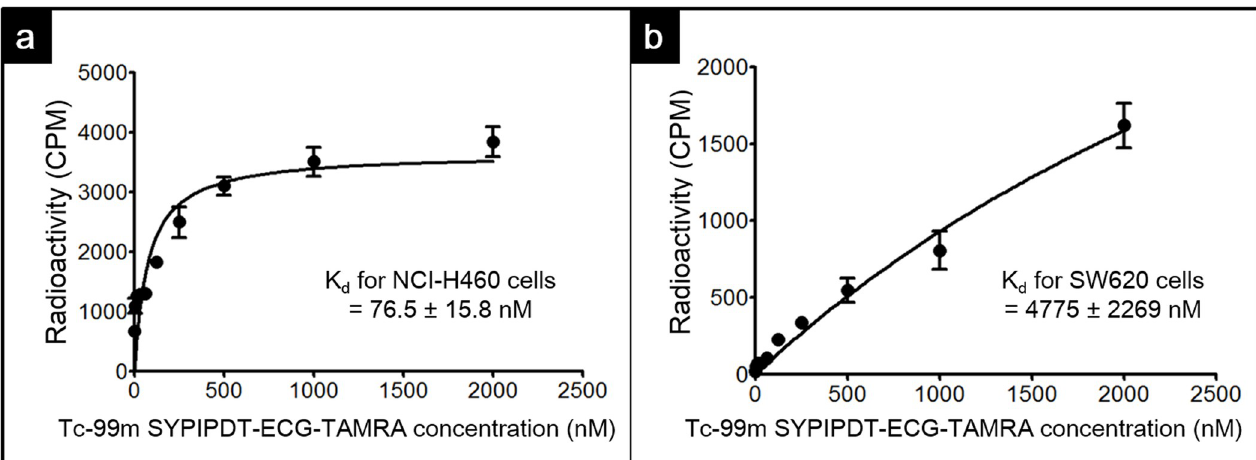
Fig 2. Cell binding affinity curves of Tc-99m SYPIPDT-ECG-TAMRA for NCI-H460 (a) and SW620 (b) cells.